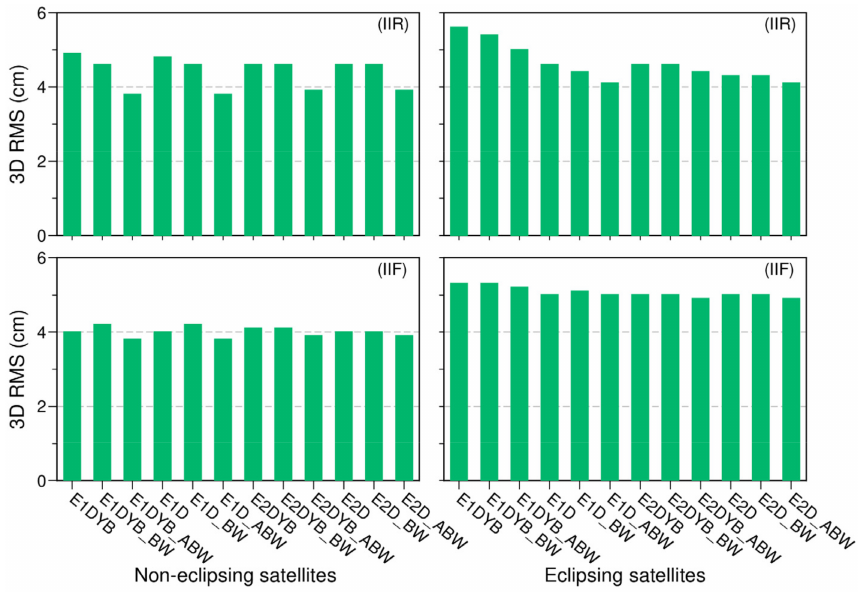
Figure 7. Mean 3D RMS of day boundary discontinuities in the 12 types of GPS daily precise orbit determination solutions spanning from 2017 to 2019. Upper panels: GPS BLOCK IIR satellites, and lower panels: GPS BLOCK IIF satellites. Left panels: satellites in noneclipsing seasons; right panels: satellites in eclipsing